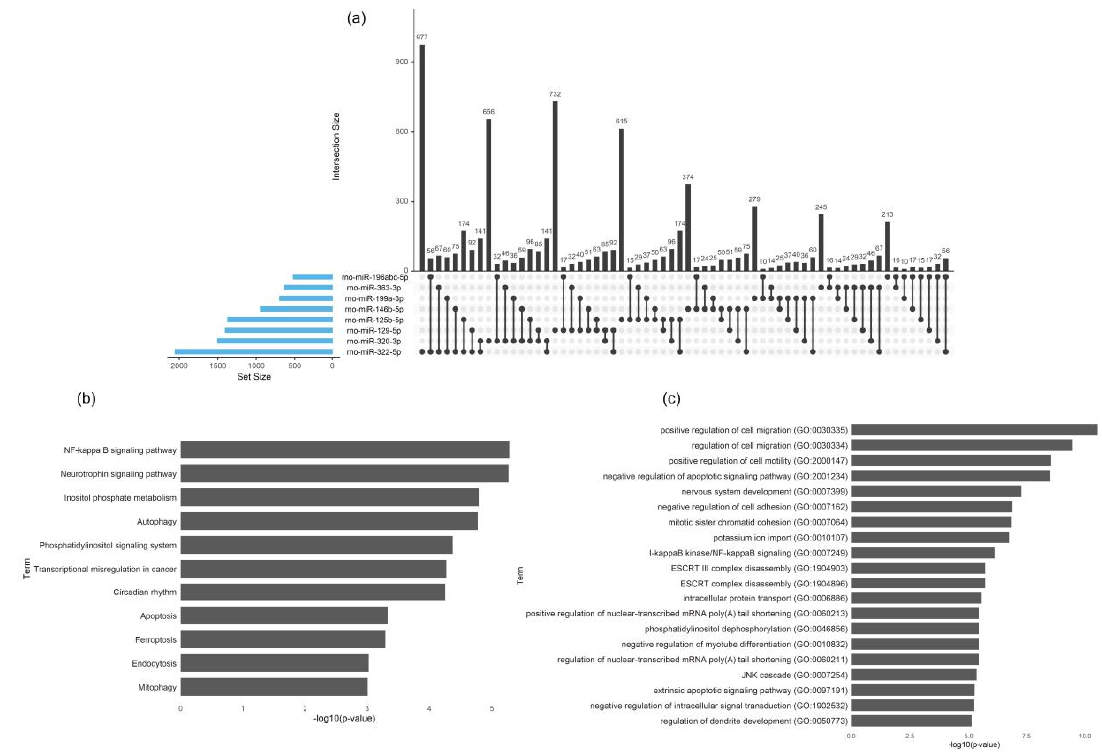
Figure 10. Transgenic Schwann cell EV cargo characterization (lacking p75 NTR or sortilin expression). ( a ) UpSet plot showing the number of predicted target genes found to be targeted by individual miRNAs or by multiple miRNAs. The plot is made using the R package “UpSetR”. The blue bars on the left side of the plot show the number of targets predicted for each miRNA. The right-side bar plot shows the number of genes targeted by only a single miRNA (single black dot in the lower right panel) or multiple miRNAs (multiple linked dots in the lower right panel). ( b ) Pathway analysis for all genes predicted to be targets of 3 or more miRNAs. All hits from KEGG pathways with p -value < 0.05. ( c ) Pathway analysis for all genes predicted to be targets of 3 or more miRNAs. The top 20 hits from Gene Ontology Biological Process.